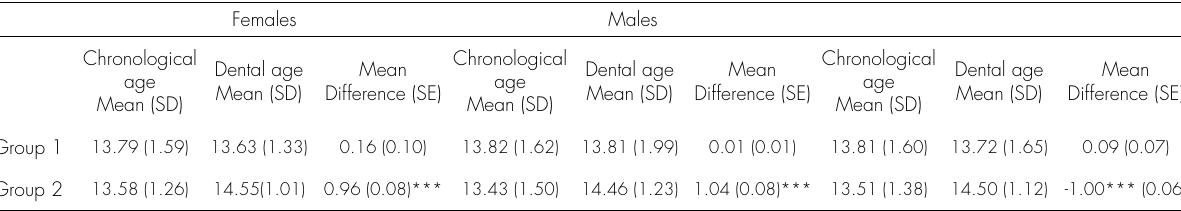
Table II. The means, standard deviation (SD), mean differences and standard error (SE), and p values of the chronological and estimated dental ages in the study groups.